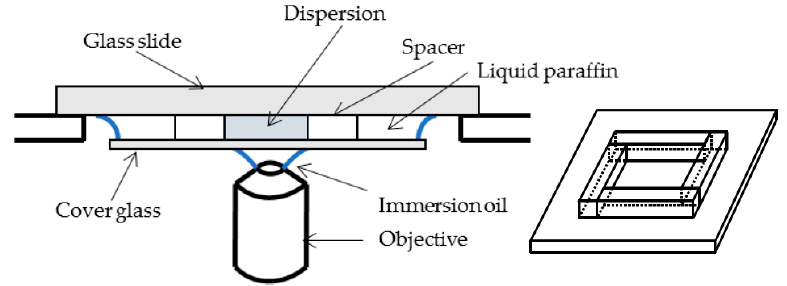
Figure 8. Schematic of an in situ observation cell. Settled particles on the cover glass formed crystals. Growth processes of the crystals were precisely observed using an oil immersion objective. A right inset figure shows the arrangement of spacers cut into four pieces (0.28 × 1.0 × 10 mm) on the glass slide. Thickness of the inner space is 0.28 mm.